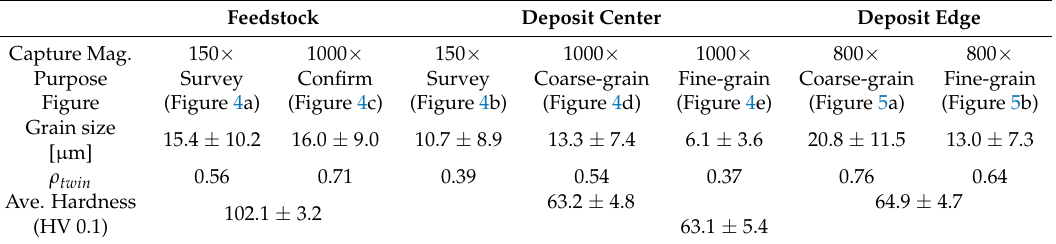
Table 1. Summary table of microstructural and material properties examined in this study. Feedstock Deposit Center Deposit Edge Capture